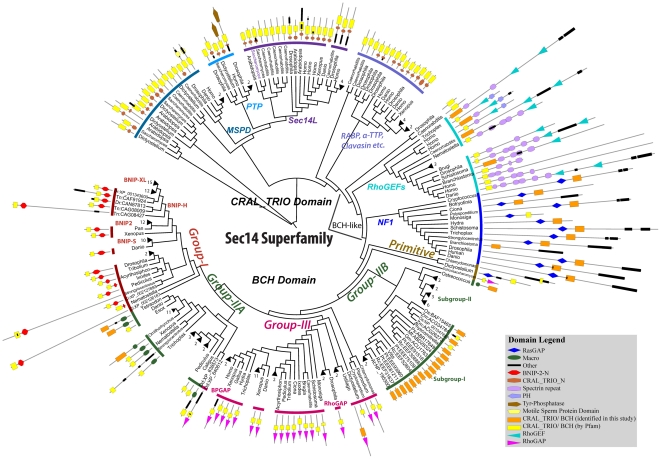
Phylogenetic tree of CRAL_TRIO and BCH domains from the Sec14 superfamily.This bootstrapped Neighbor Joining tree includes 175 BCH domains and 98 CRAL_TRIO/BCH-like domains from multiple organisms. The tree is displayed in a circular mode and different groups are marked by colored stripes. The clades with branch length <0.05 are collapsed and the number against each collapsed clade gives the number of collapsed branches. Branch lengths are ignored in order to maintain clarity. Against each branch the domain architectures of individual protein are shown as identified by the Pfam database (release 25) with a cut-off e-value ≤0.1. The Pfam database does not differentiate between CRAL_TRIO and BCH domains and thus both are indicated by yellow colored rectangles. However, if no such domain was identified by the Pfam database, we marked the annotations for BCH domains as determined by our analyses and they are indicated by an orange colored rectangle. The protein length is scaled. Eexcept when there is more than one protein from one genus (for these NCBI accessions are also given with name initials) only the generic names are given. The accession codes for remaining species/branches can be found in the Table S1. The abbreviations used are as follows; Dr: Danio rerio, Tn: Tetraodon nigroviridis, Ci: Ciona intestinalis, Dd: Dictyostelium discoideum, At: Arabidopsis thaliana, Rc: Ricinus communis, Pt: Populus trichocarpa, Gm: Glycine max, Mt: Medicago truncatula, Ps: Picea sitchensis, Zm: Zea mays, Os: Oryza sativa. This phylogenetic tree shows the distinct clustering of BCH domains from CRAL_TRIO domains. The three BCH subgroups are group I, group II and group III respectively and distinct groups within the CRAL_TRIO domain are also marked accordingly. Each cluster represents a distinct domain architecture. Pfam does not recognize the complete domain in BCH groups. The CRAL_TRIO_N domain, which is characteristically associated with CRAL_TRIO domains, is also missing in BCH and BCH-like (NF1 and RhoGEF) proteins. Similar to NF1 protein, Dictyostelium discoideum has an ancestral BCH sequence, which is associated with a RasGAP domain.